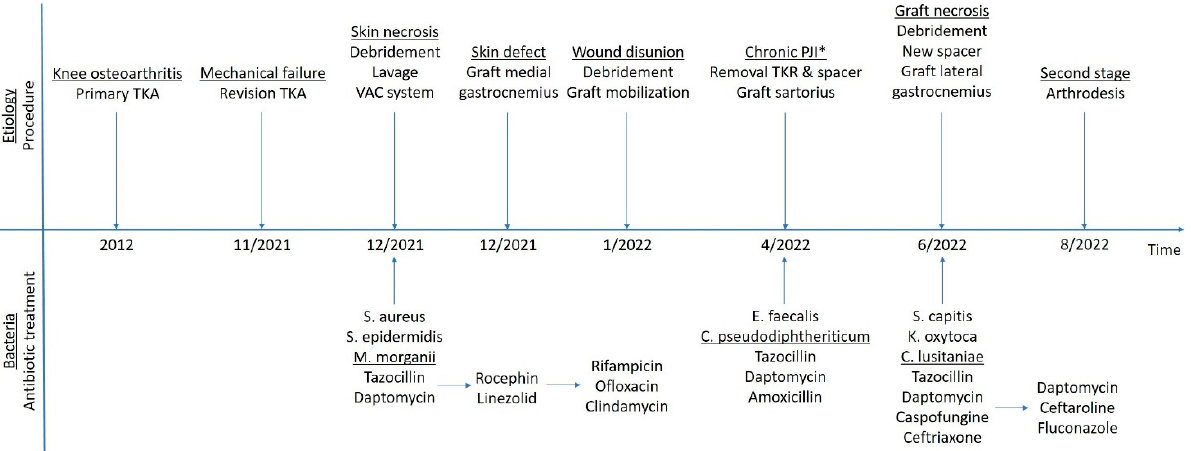
Figure 4. Anteroposterior post-operative radiographic view of a prosthesis-arthrodesis implant. Four months after the last operation, she was free from pain and had no signs of PJI.